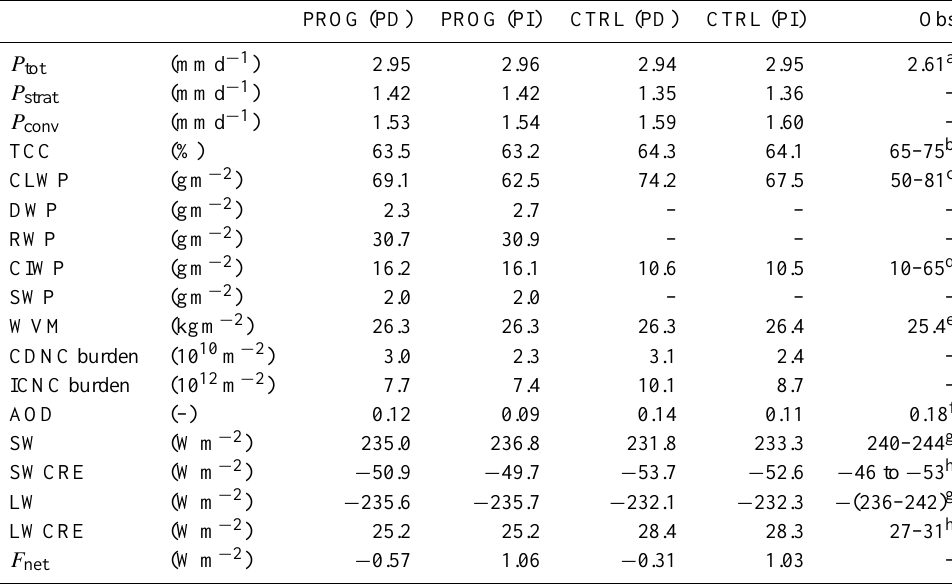
Table 2. Global annual mean cloud properties and TOA energy budget for the simulations performed with ECHAM5-CTRL and ECHAM5- PROG (2000–2011) as well as observations. Also shown are the water vapor mass (WVM) and for ECHAM5-PROG the drizzle, rain and snow water path (DWP, RWP and SWP, respectively).